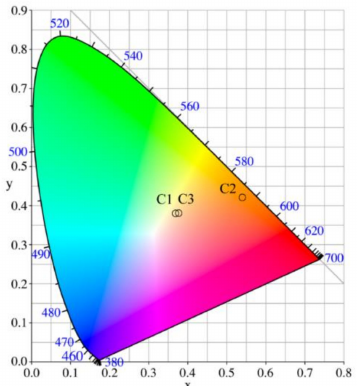
Figure 10. CIE 1931 x, y color space chromaticity diagram with the color calculation results circled for the C series samples in their various states C1, C2, and C3 using the CIE D65 illuminant. Notice the more pronounced color for sample C2 compared to the sample C above. C1 and C3 give almost the same color